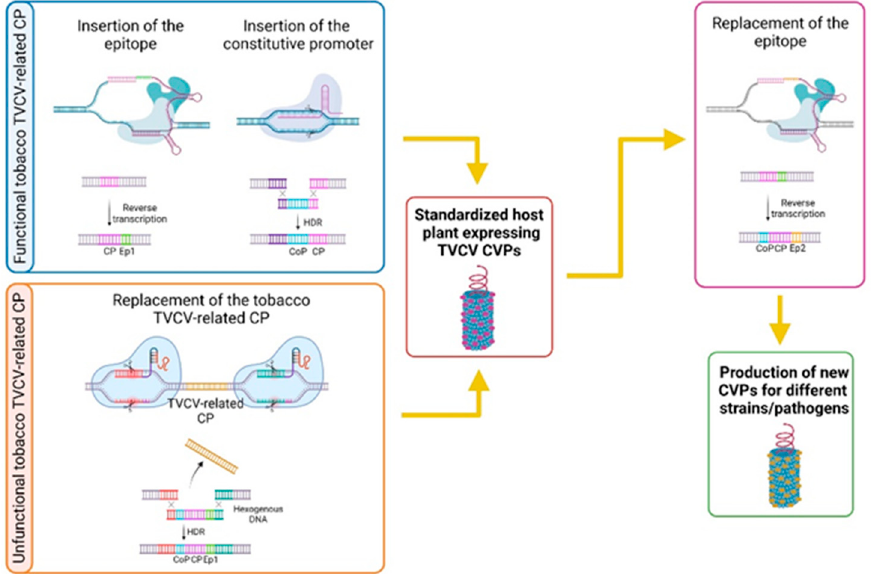
Figure 5. Steps for the generation of a standardized tobacco host for vaccine production through the association between CVP and genome editing techniques. Genome editing can be used to manipulate the TVCV-like sequences integrated in N. tabacum genome showing high sequence similarity to TVCV CP encoding ORF. Two possible strategies can be postulated depending on the ability of the tobacco CP corresponding sequences to generate VLPs. (1) Functional tobacco TVCV-related CPs: a small epitope encoding sequence can be fused to the tobacco CP-related ORF by prime editing; a constitutive promoter region can be integrated upstream the CP-related ORF by CRISPR-Cas9 taking advantage of HDR. (2) Unfunctional tobacco TVCV-related CP: the tobacco CP-related sequence could be replaced by the TCVC CP ORF carrying a constitutive promoter and the epitope encoding sequence by using CRISPR-Cas9 with sgRNAs targeting sites flanking the tobacco locus. The standardized host plant, able to produce functional CVPs, can be successively modified by replacing the epitope sequence through base editing in order to obtain functional CVPs towards different pathogens/strains. CP = coat protein, Ep1 = epitope 1, Ep2 = epitope 2, CoP = constitutive promoter. Created with Biorender.com (https://biorender.com/; accessed on 20 April 2021). A small linker, as suggested by Werner et al. [120] could be also inserted. The obtained CP–epitope sequence might represent the target site of prime editing and/or CRISPR/Cas9 aimed at replacing the epitope encoding sequence for the generation of different CVPs specific for different strains or pathogens (Figure 5).